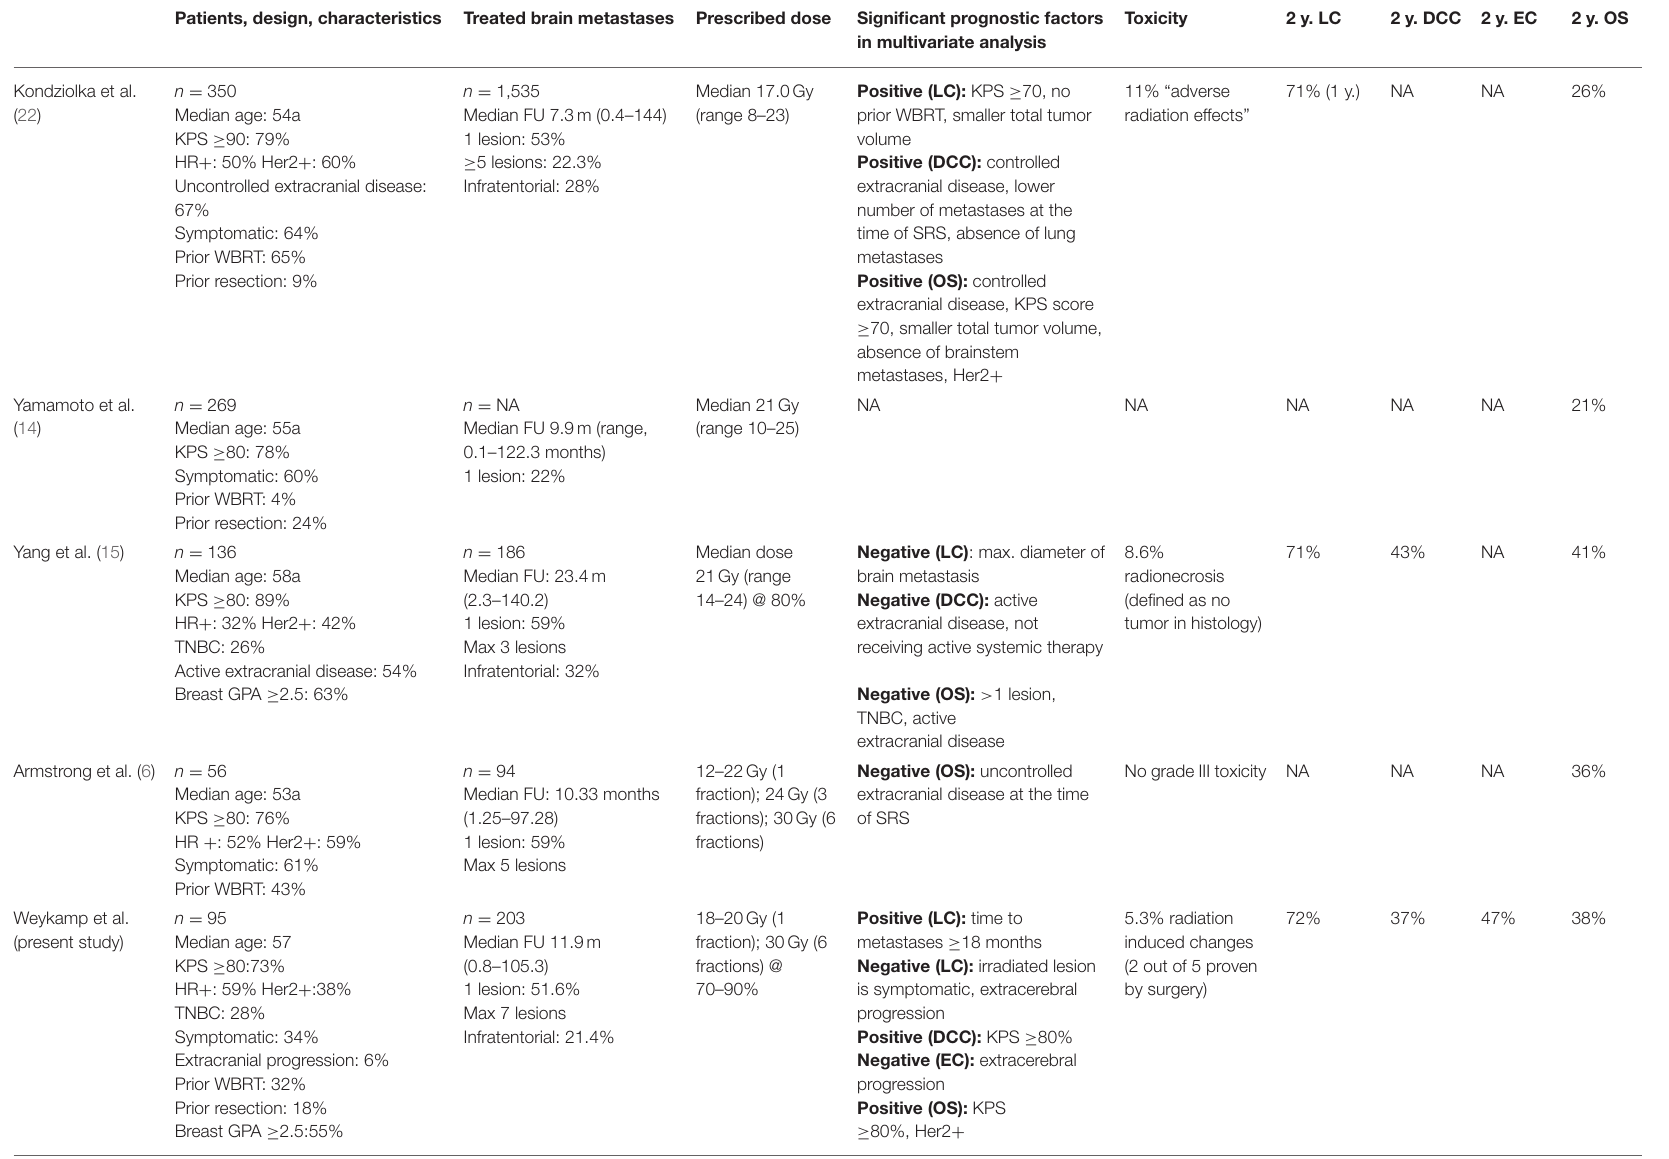
TABLE 7 | Larger recent studies on radiosurgery only for brain metastases in female breast cancer patients. Patients, design, characteristics Treated brain metastases Prescribed